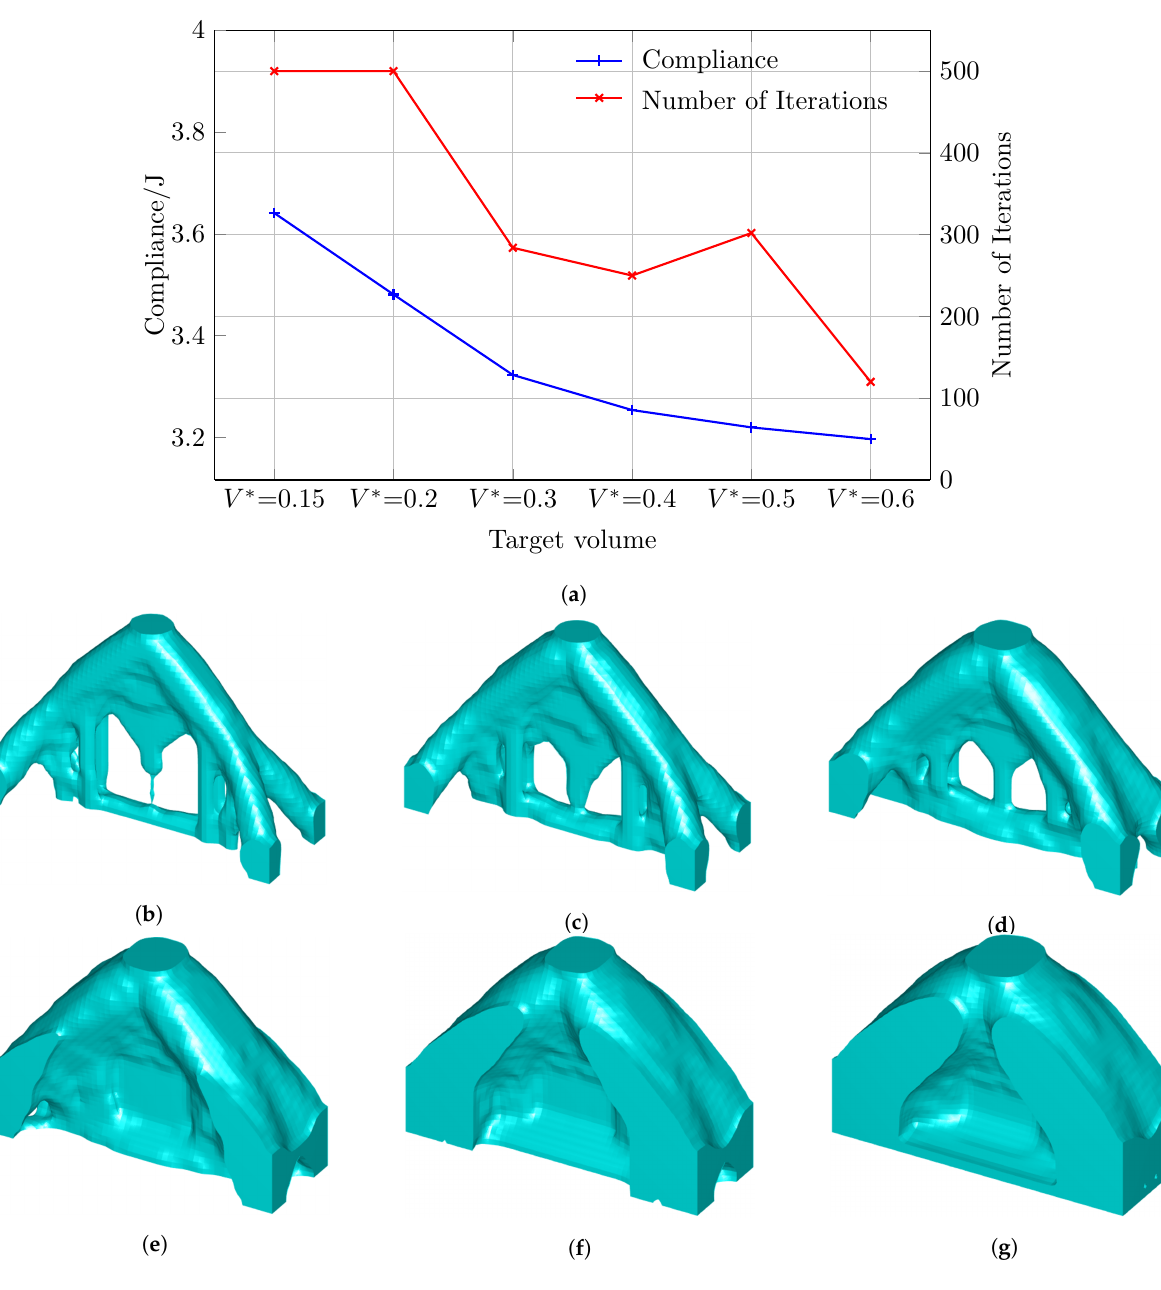
Figure 5. Compliance, number of iterations and optimized topologies with different target volume fractions: ( a ) compliance and number of iterations, ( b ) V ∗ = 0.15, ( c ) V ∗ = 0.2, ( d ) V ∗ = 0.3, ( e ) V ∗ = 0.4, ( f ) V ∗ = 0.5, ( g ) V ∗ =